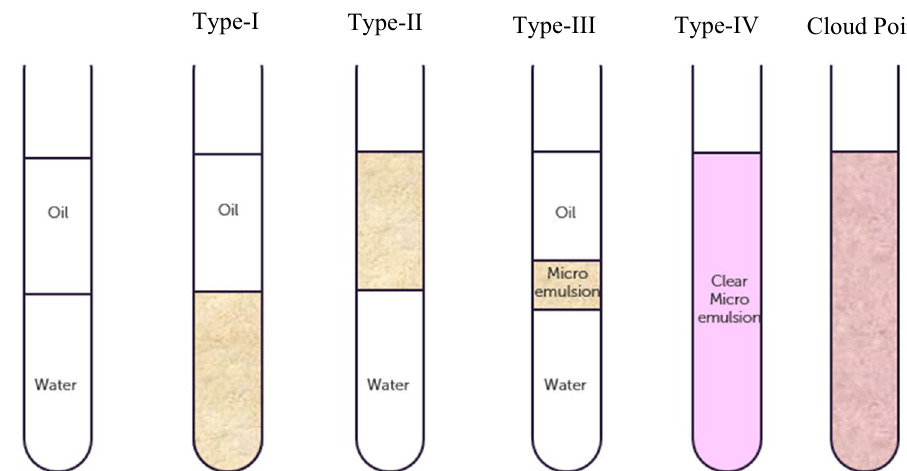
Fig. 1 Winsor classification of emulsions (Winsor